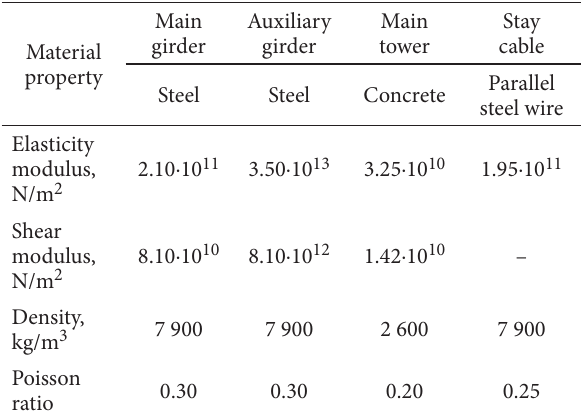
Fig. 1. Finite element analysis model of Sutong highway bridge Table 1. Material mechanical properties